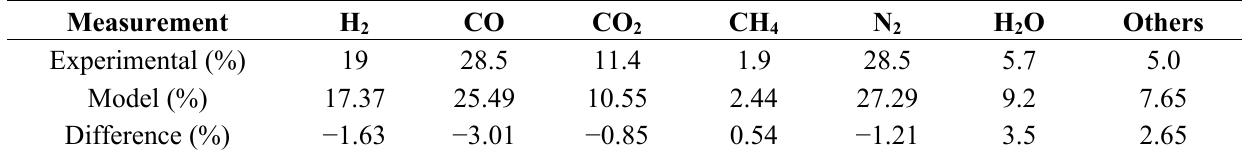
Table 5. Comparison of experimental and simulation result of SW gasification.